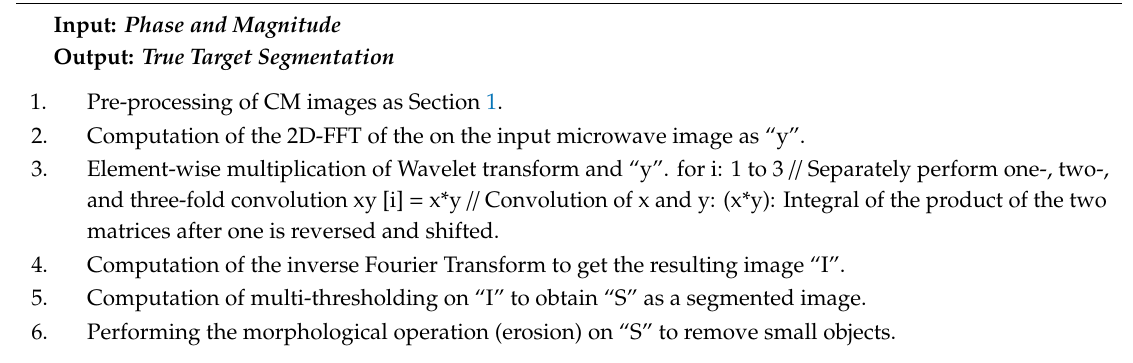
Pseudocode 2. The proposed FT-based algorithms for defect segmentation in microwave